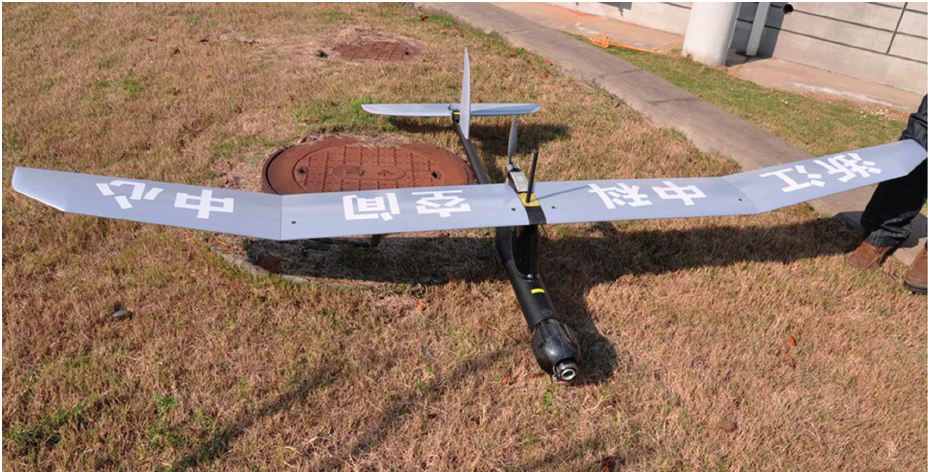
Figure 1. Workflow of urban vegetation mapping using Unmanned Aerial Vehicle (UAV) imagery.